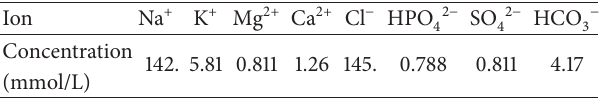
Table 1: Concentrations of inorganic ions in the HBS